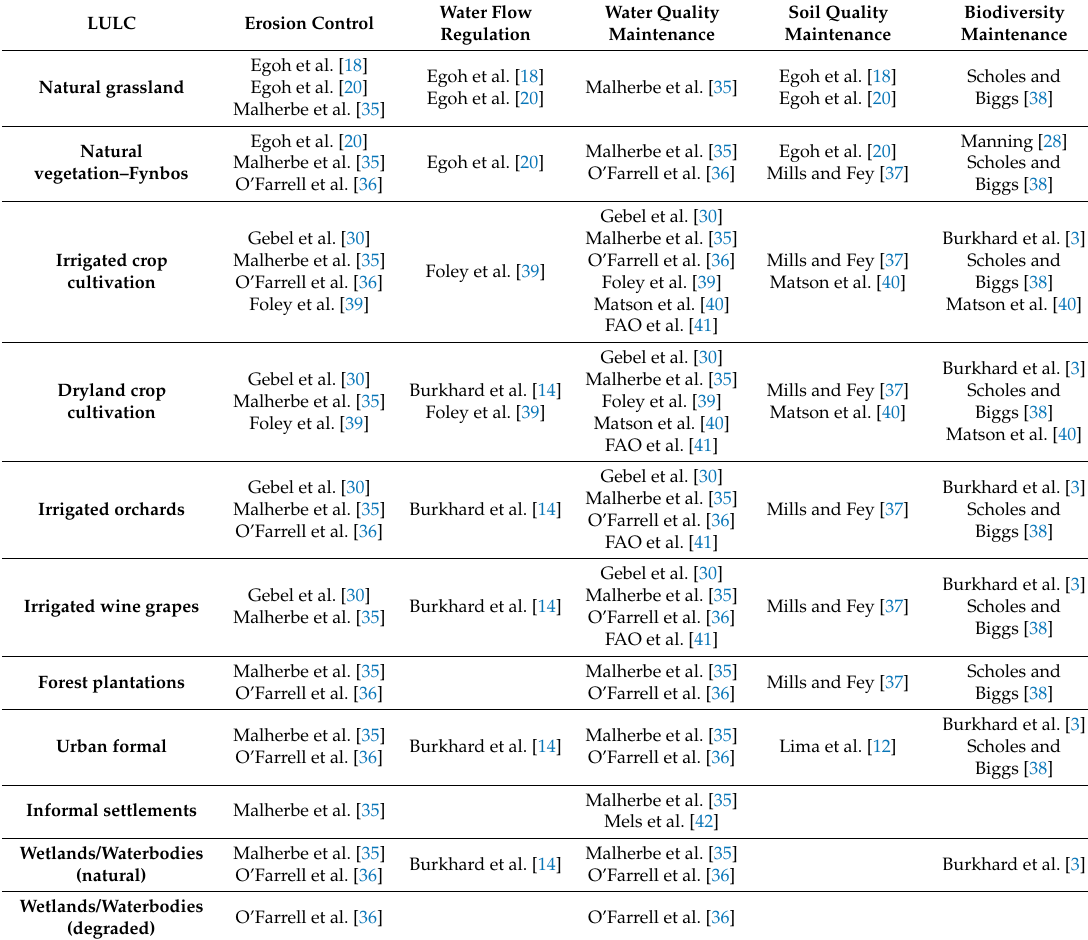
Table 1. References used to assign the values of land use/land cover (LULC) and ecosystem services.